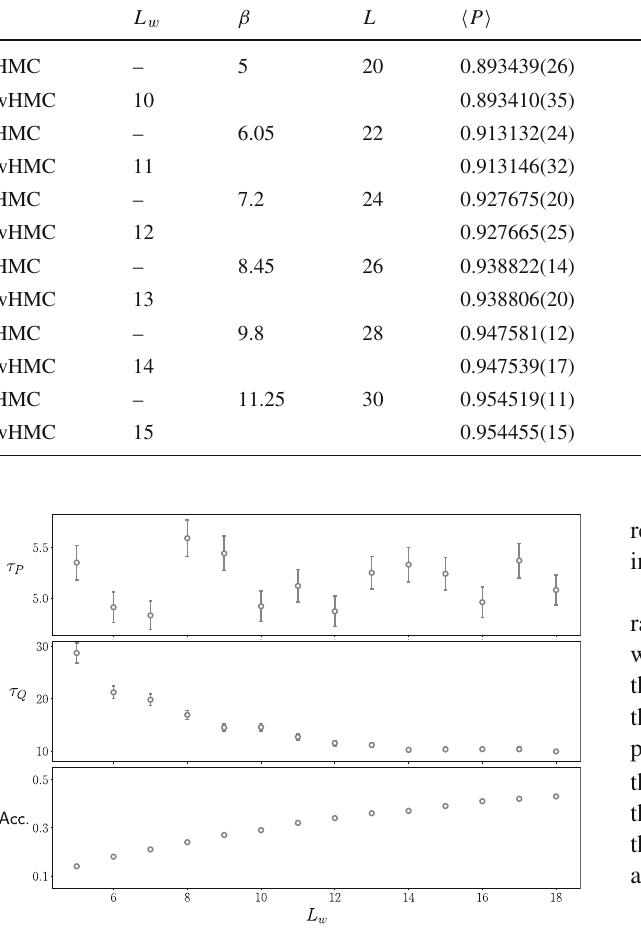
Fig. 5 Dependence on the winding size, L w , of the plaquette autocor- relation time (top panel), the topological charge autocorrelation time (middle) and the acceptance of one winding step (bottom panel), at β = 5